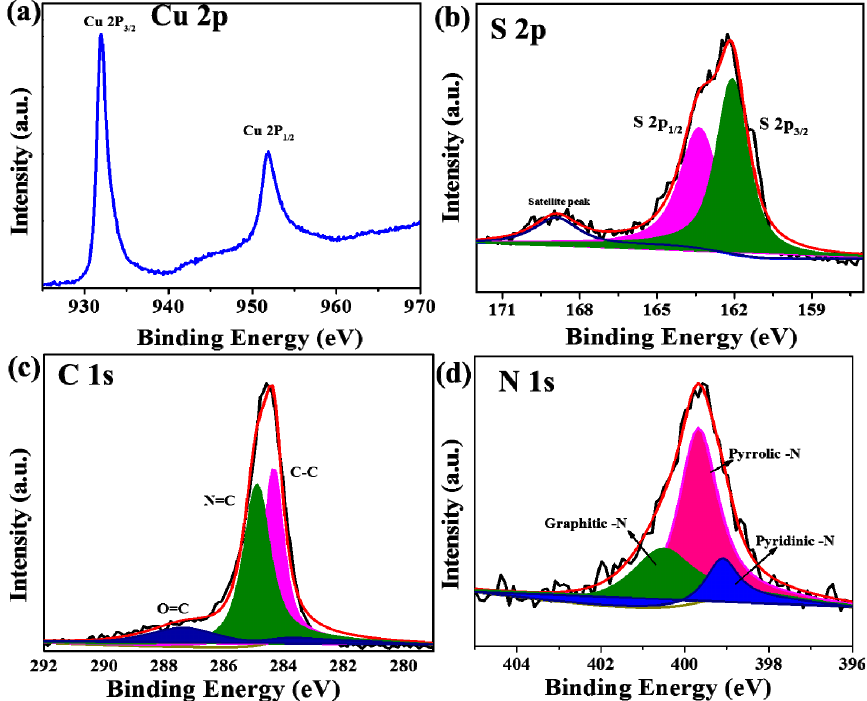
Figure 3. XPS spectra of CuS-CNF: ( a ) high resolution Cu 2p spectrum, ( b ) high resolution S 2p spectrum, ( c ) high resolution C 1s spectrum, and ( d ) high resolution N 1s spectrum.